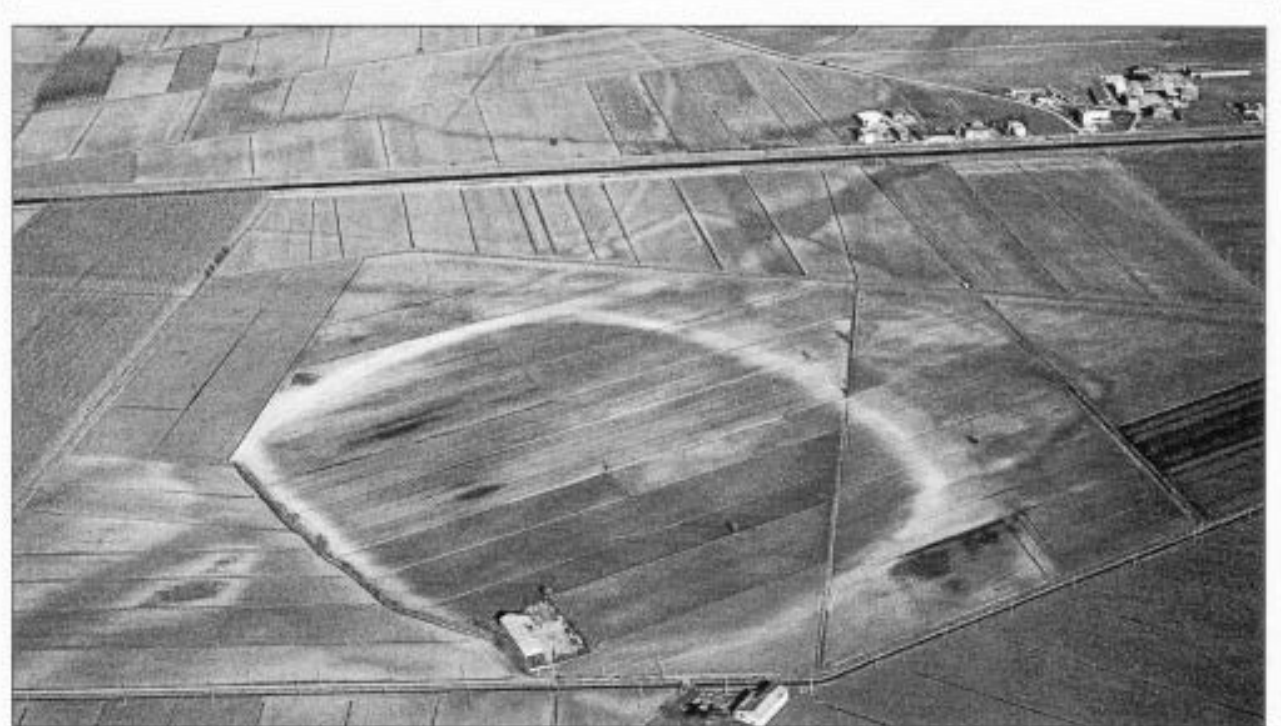
Figure 3 Aerial photograph and plan of one of the main Bronze Age sites, Castello del Tartaro, showing natural water courses and artificial ditches of both Bronze Age and Roman date. human occupation. We have good evi­